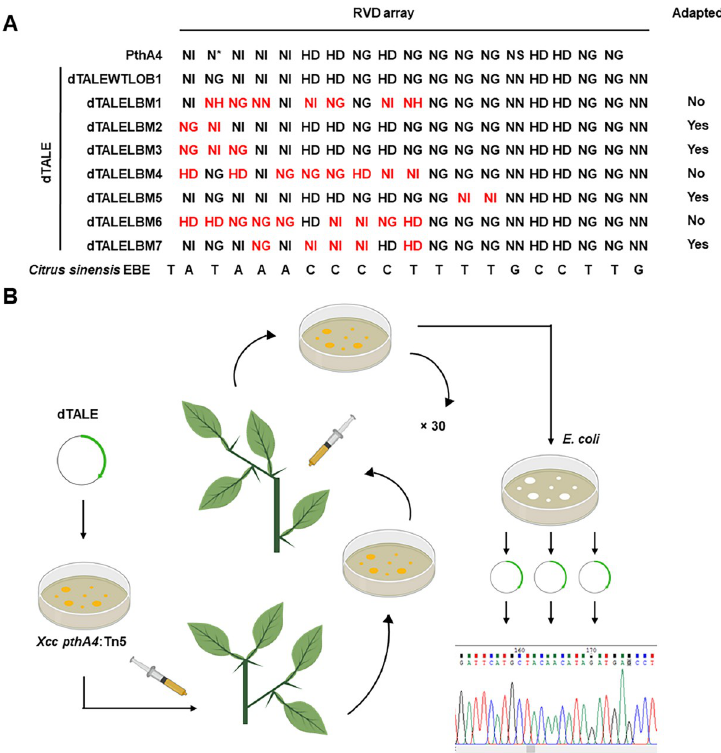
Fig 2. Experimental evolution of TALEs. A. RVD repeat arrays of PthA4 (XACb0065) and dTALEs used in experimental evolution test. The nucleotide sequence of the effector-binding element of CsLOB1 from sweet orange ( Citrus sinensis ) is represented at the bottom. “Adapted” column indicates whether the dTALE variant was able to adapt in the duration of the experiment. B. Schematic representation of the experimental evolution workflow. Scheme was created with Biorender